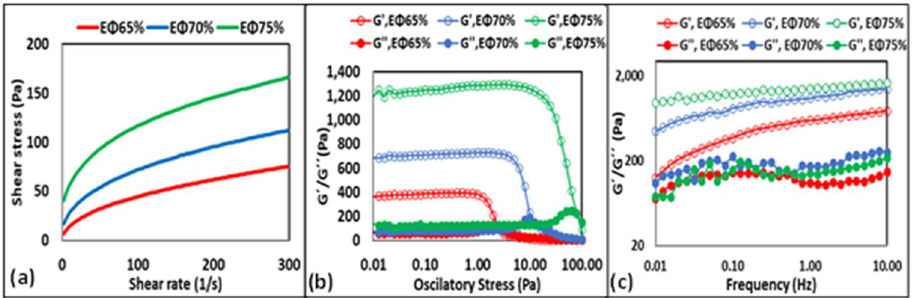
Figure 3. Flow curves plotted as shear stress versus shear rate ( a ), stress sweeps ( b ), and frequency ( c ) tests of EΦ65%, EΦ70%, and EΦ75 % at day 0 of storage at 25 °C.